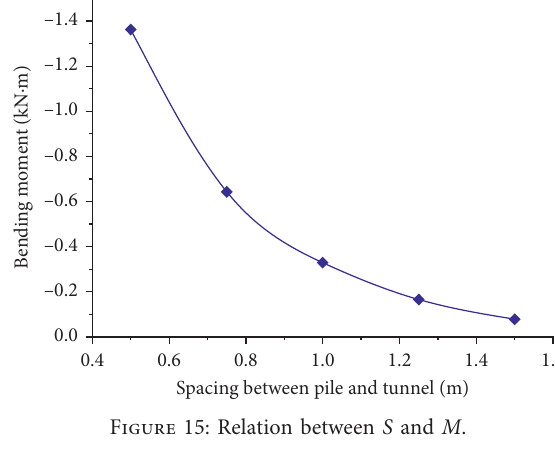
Figure 14: Relation between k